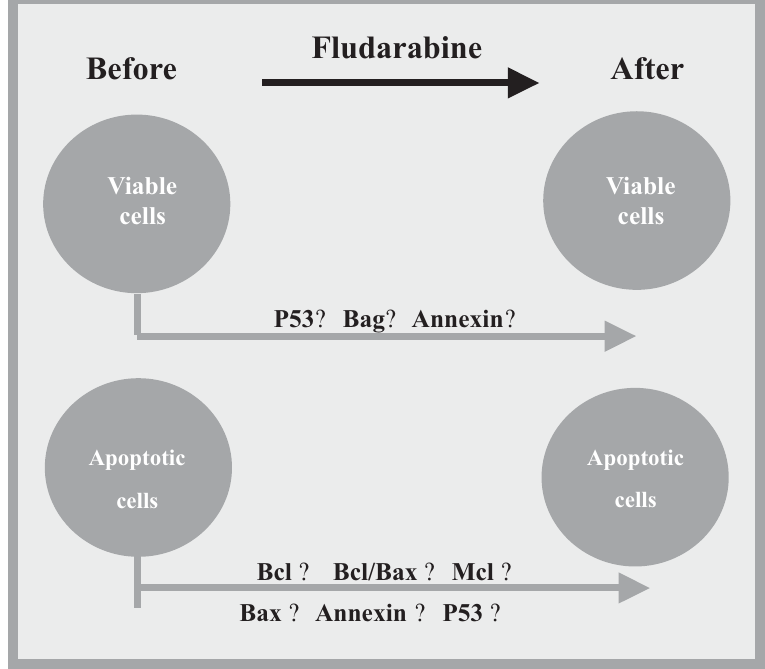
Figure 1. Significant modifications in the protein expressions before and after fludarabine